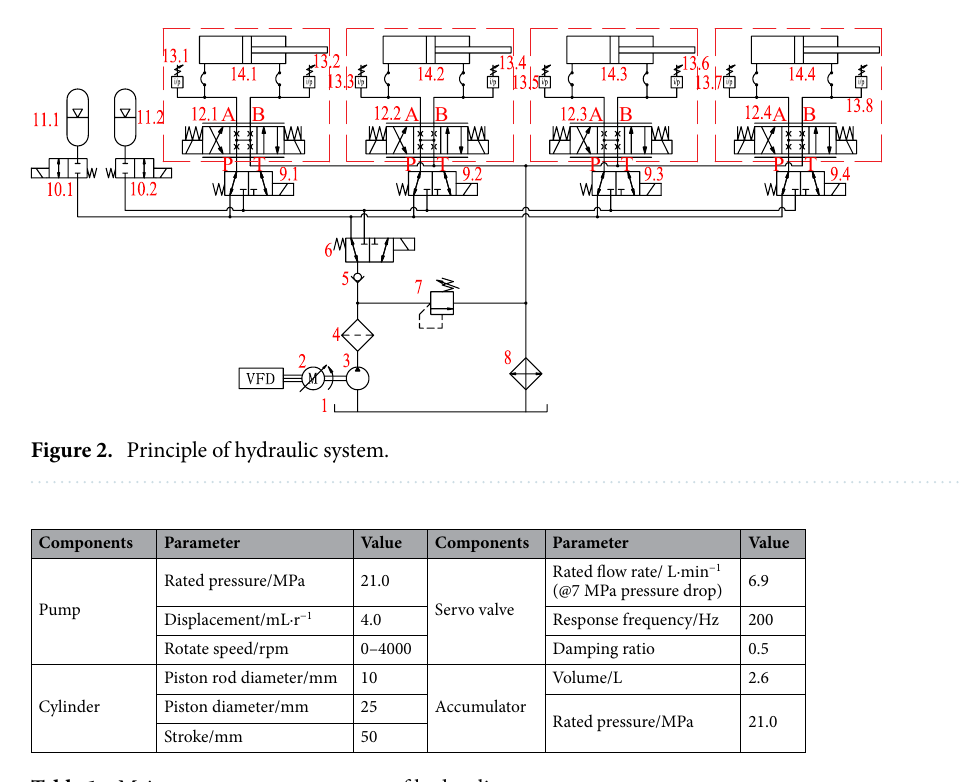
Table 1. Main components parameters of hydraulic